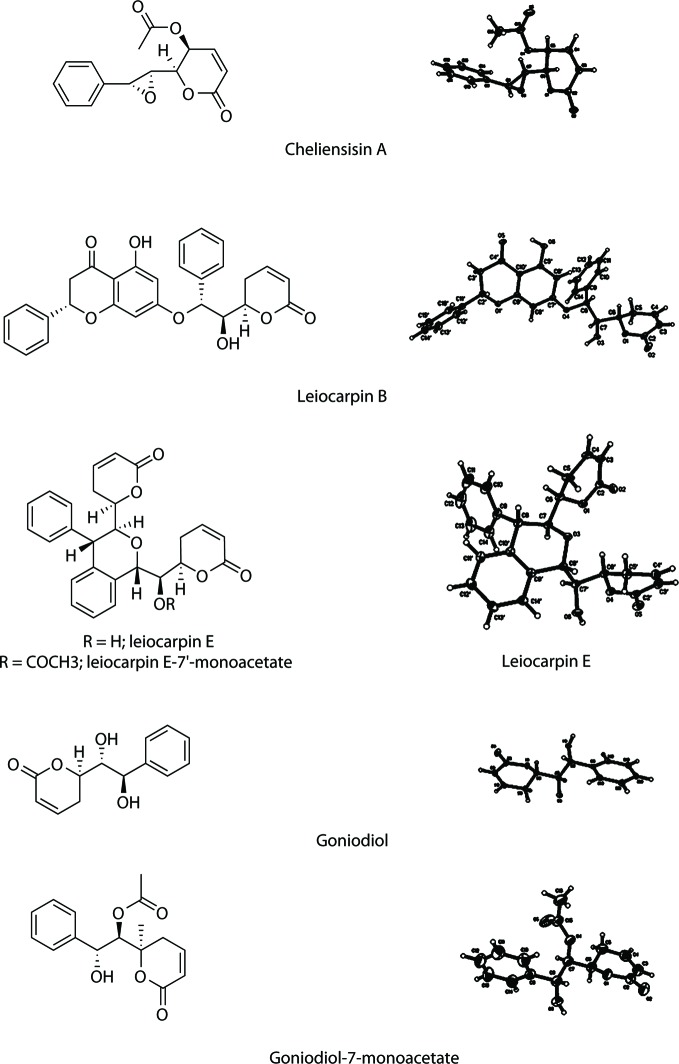
Structure and X-ray crystallography of the styryllactones.